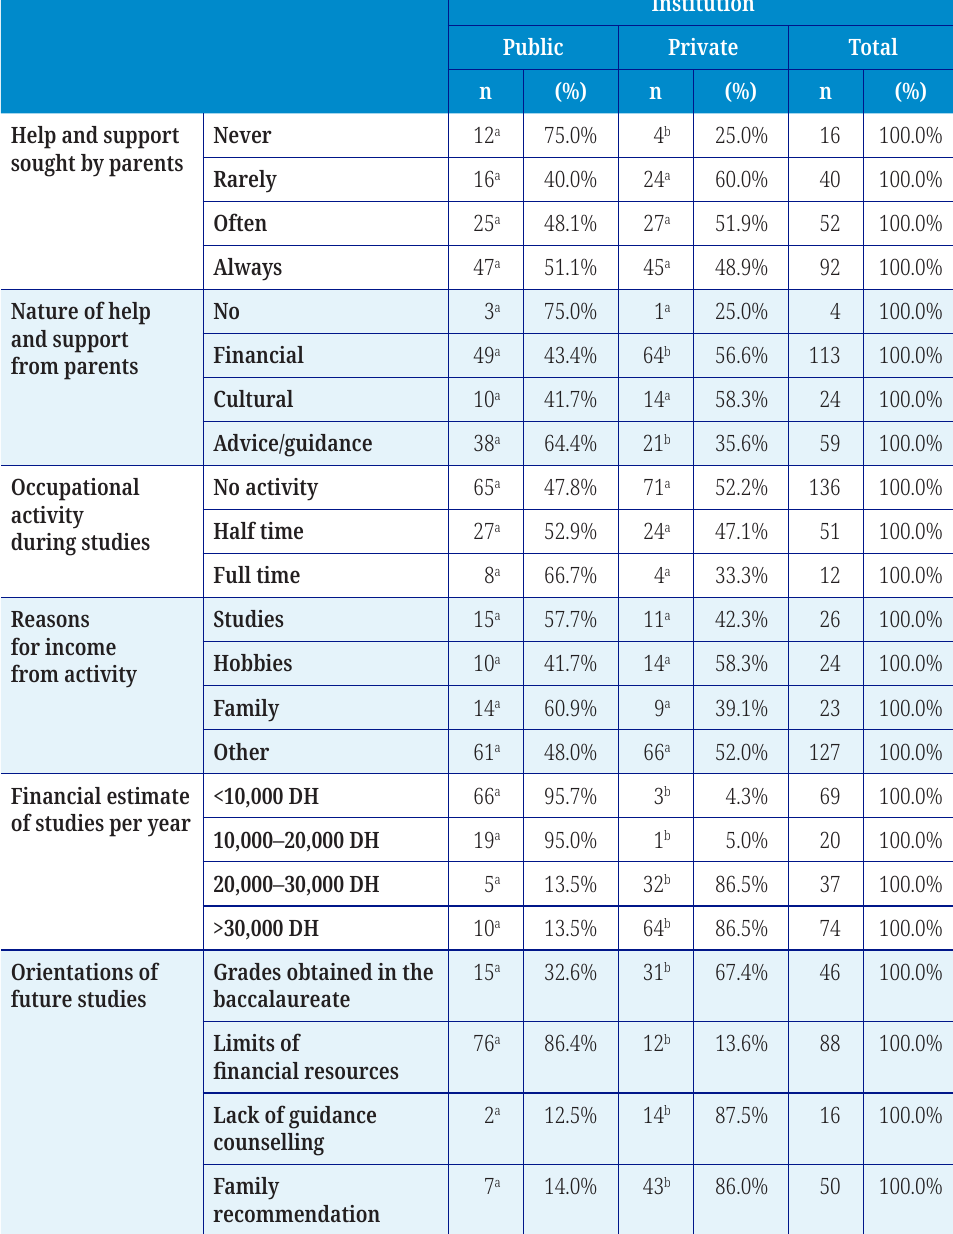
Table 11. Financial and cultural autonomy of public/private university